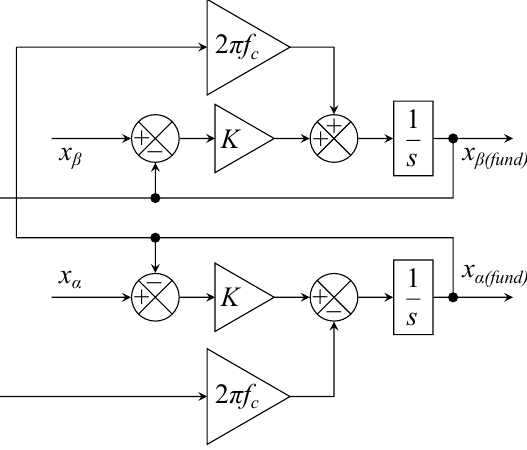
Figure 22. Self-tuning filter principle